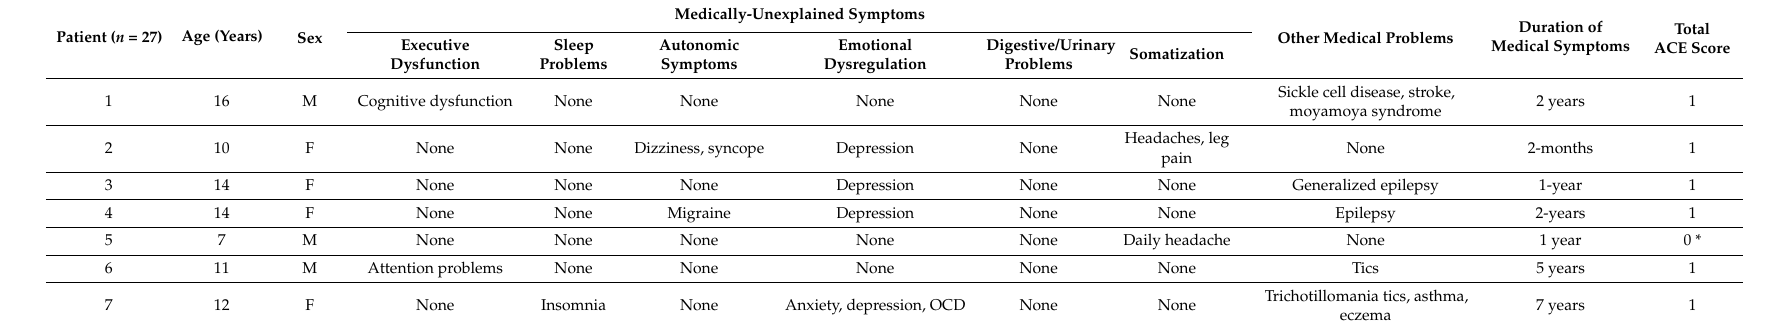
Table 2. Group B: Patients with adverse childhood experiences with 0–3 medically unexplained